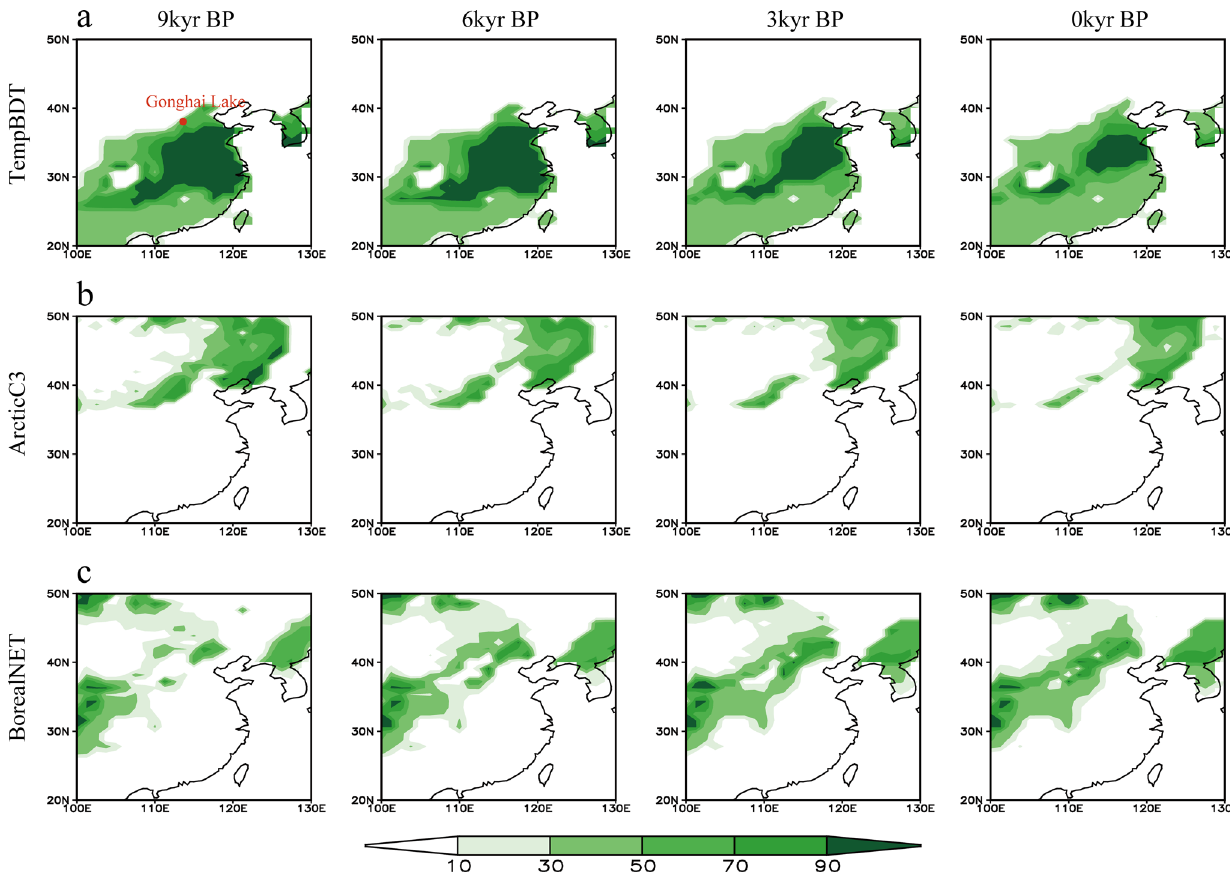
Fig. 2 Distribution of typical vegetation in East Asia at 9, 6, 3, and 0 kyr BP. a The temperate broadleaf deciduous trees (TempBDT); b The Arctic C 3 plants (ArcticC3); c The boreal needleleaf evergreen trees (BorealNET). These fi gures are generated using GrADS v1.5.1.12 71